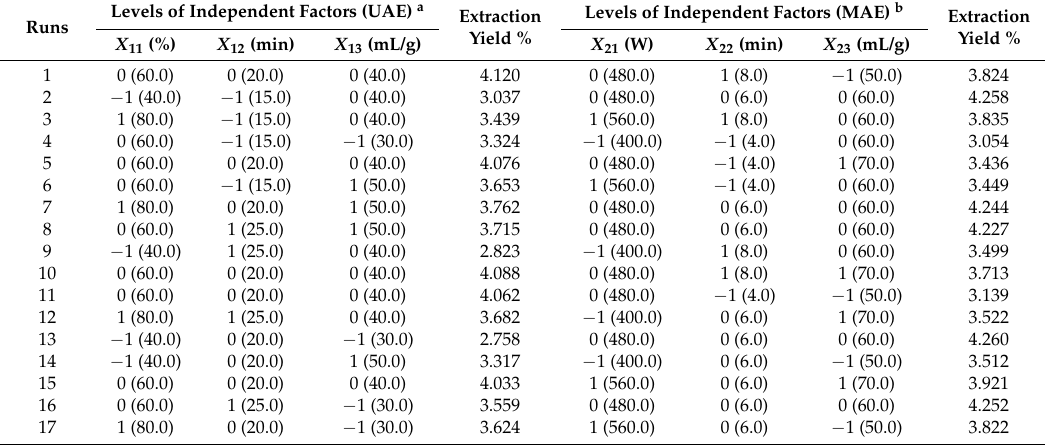
Table 1. The Box–Behnken design with independent variables and observed values for ultrasonic-assisted extraction (UAE) and microwave-assisted extraction